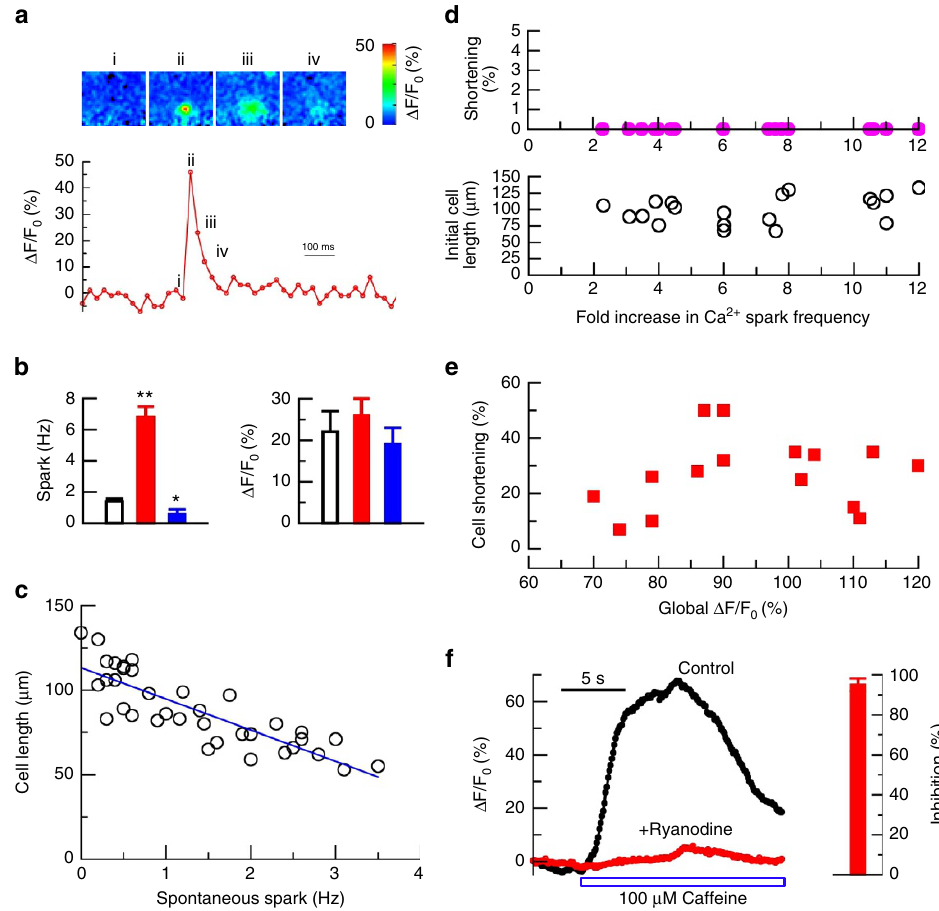
Figure 3 | RyR-mediated global [Ca 2 þ ] i , but not Ca 2 þ sparks, contracts IAS-SMCs. ( a ) Top panels show the spatiotemporal evolution of a single Ca 2 þ spark in an IAS-SMC, and the Roman numerals correspond to the time marked on the trace of time course of D F/F0 (%) (a proxy for the change in [Ca 2 þ ] i at the epicentre pixel (333 (cid:3) 333nm) of this spark. ( b ) Effects of caffeine (180 m M, red bars) and ryanodine (100 m M, blue bars) on Ca 2 þ sparks. Bars represent mean ± s.e.m., n ¼ 20 cells for caffeine, and n ¼ 4 cells for ryanodine. * P o 0.05; ** P o 0.01 by two-tailed Student’s t -test. ( c ) Calcium spark frequency was inversely correlated with cell length (Pearson correlation coefficient: (cid:2) 0.8398, P o 0.0001 by two-tailed Student’s t -test; n ¼ 36). ( d ) Ca 2 þ spark activity was increased by caffeine (30, 200 or 500 m M) but did not associate with any detectable shortening (upper panel) of cells with different initial lengths (lower panel; Pearson correlation coefficient: 0.3409, P 4 0.05 by two-tailed Student’s t -test; n ¼ 19). ( e ) An increase in global [Ca 2 þ ] i by 1 or 10mM caffeine did cause cell shortening by 27.0 ± 3.4% on average ( P o 0.01 by the Student’s t -test; n ¼ 15) although no correlation exists between the magnitude of the caffeine-induced global [Ca 2 þ ]i and amount of cell shortening (Pearson correlation coefficient: 0.1596, P 4 0.05 by the Student’s t -test; n ¼ 15). ( f ) Ryanodine (100 m M) blocked the caffeine-induced calcium increase. The bar chart on the right is the mean ± s.e.m. Per cent inhibition by ryanodine for six